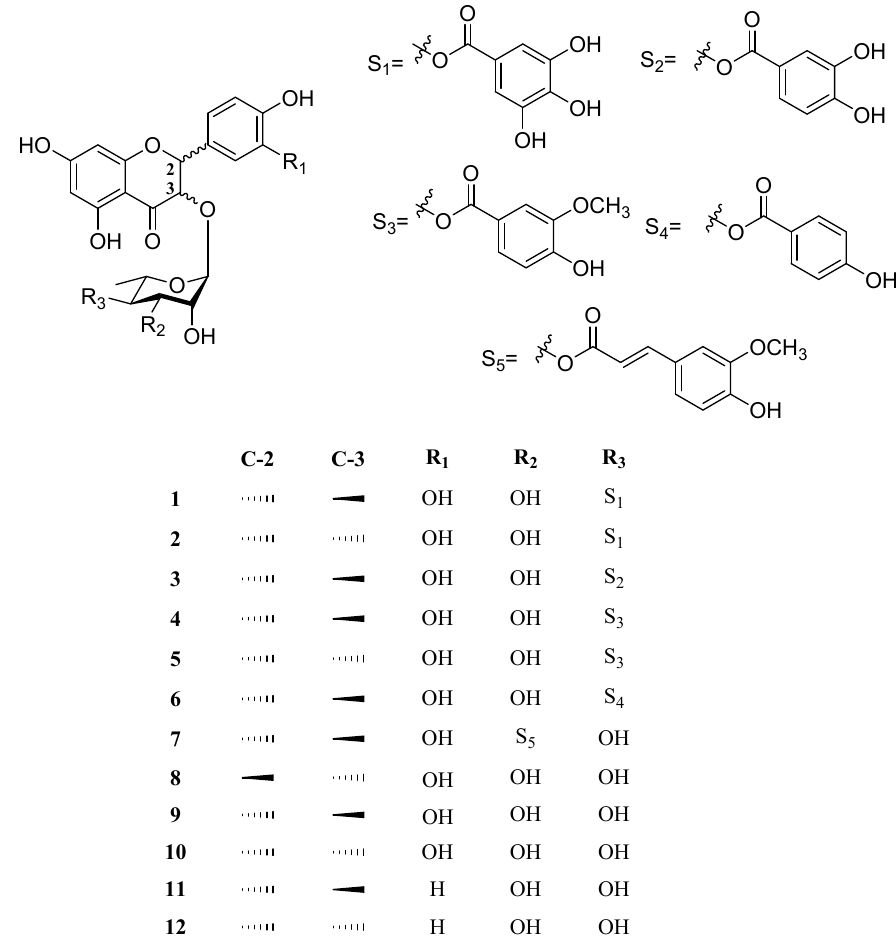
Figure 2. The structures of the isolated flavanonol glycosides from M. seguinii .